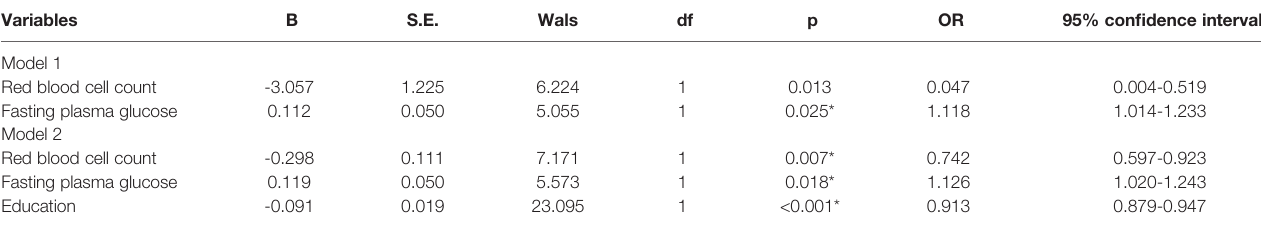
TABLE 2 | Results of binary logistics regression analysis (with MCI as the dependent variable).